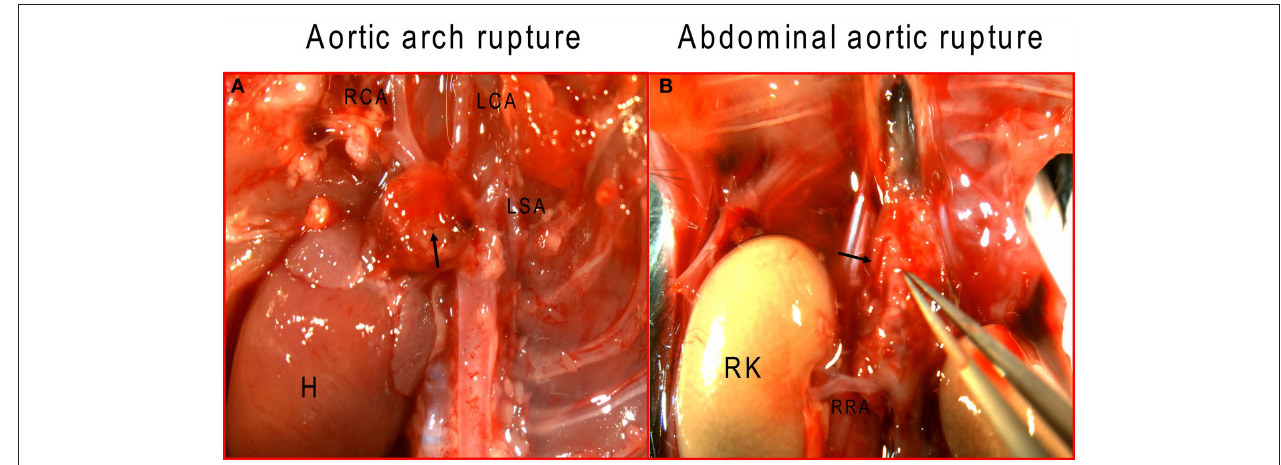
FIguRE 1 | Ang II induces aortic rupture not only in the abdominal aorta but also in the aortic arch. (A) Aortic arch, with major branches, was dissected to ascertain the exact rupture site; (B) abdominal aorta was dissected from